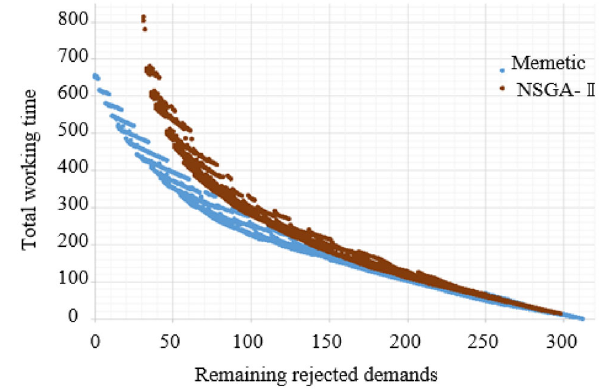
Fig. 9 Total working time according to the number of rejected demands